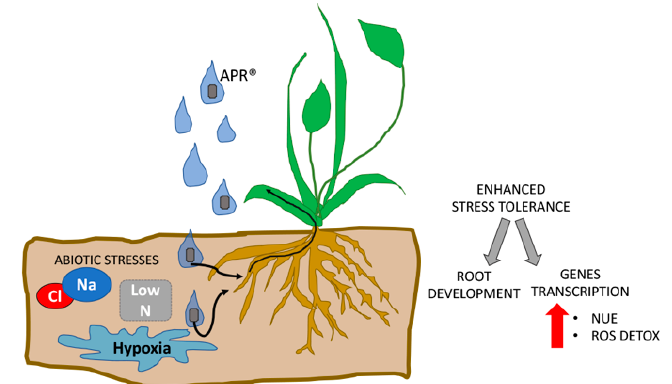
Figure 8. Direct and indirect effects of APR on plant growth in response to single and combined abiotic stresses. APR is perceived by the roots and modulates the root length by balancing the expression of genes involved in nitrate transport and ROS detoxification. APR could be systemically transported to the upper part of the plant, inducing a growth response in the shoot. Supplementary Materials: The following are available online at www.mdpi.com/xxx/s1, Table S1: List of primers used in gene expression analysis.